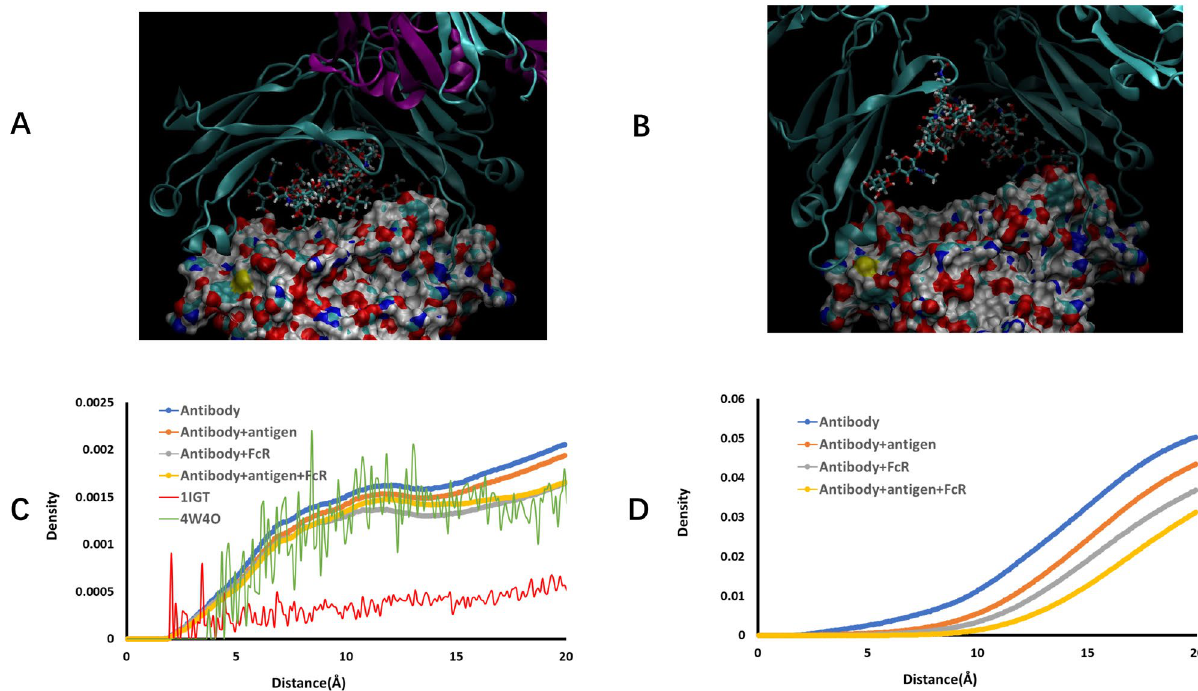
Figure 4. Two carbohydrate chains interact with Fc CH3 domain residues in free antibody conformation ensemble. (A) and (B) Snapshots of carbohydrate-CH3 domain interaction in free antibody and antibody-antigen complex, respectively. CH2 domain proteins chains are represented by ribbons, and CH3 domains are shown as solid surface. carbohydrate residues are depicted as stick bonds; (C) distance distribution of fucose residue from antibody amino acid residues; (D) distance distribution of carbohydrate residues from CH3 domain amino acid